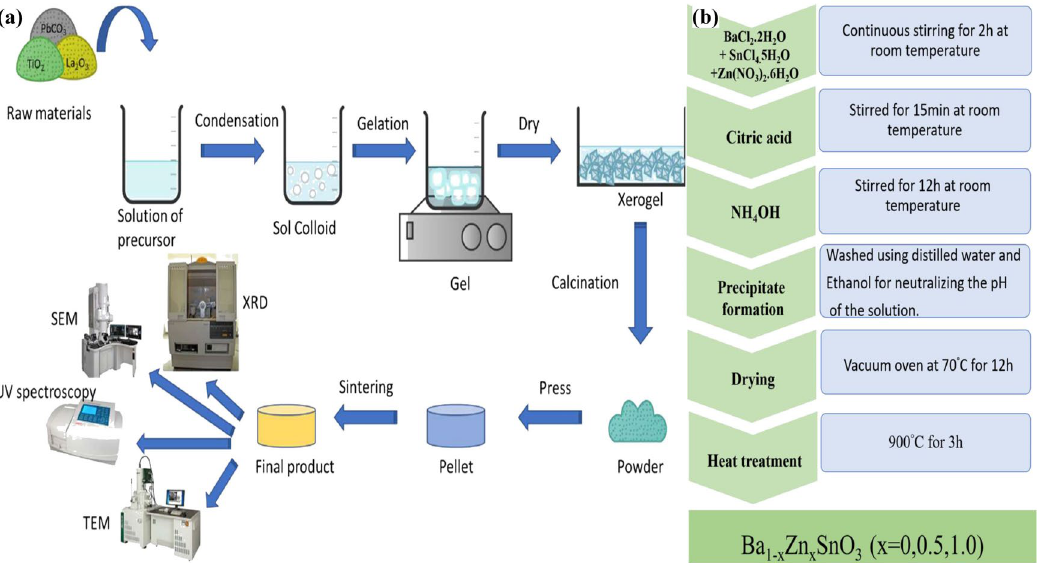
Figure 3. ( a ) Sol-gel method. Reprinted with permission from [32] © 2020 Elsevier Ltd. ( b ) Zn-doped BSO by co-precipitation method. Reprinted with permission from [34] © 2021 Elsevier Ltd.